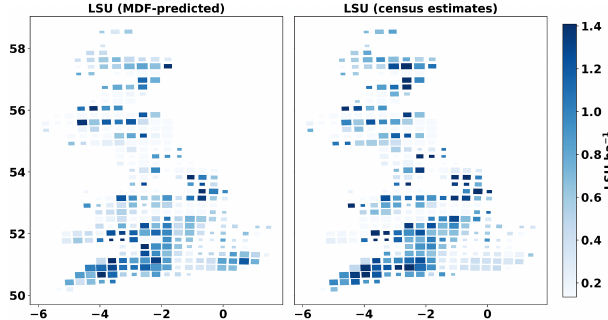
Figure 4. Cartograms of census-based and MDF-predicted live- stock density (livestock units, LUha − 1 ). The size of cells is ad- justed according to the number of simulated fields within